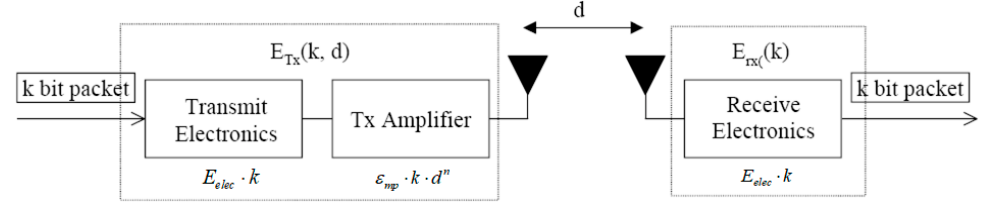
Figure 2. The energy model.